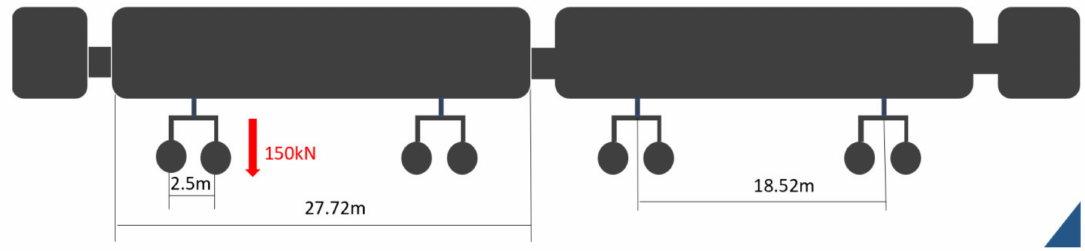
Figure 4. The train configuration with car length, bogie distance, and axle distance. The damaged track structure and the response are not homogeneous along the